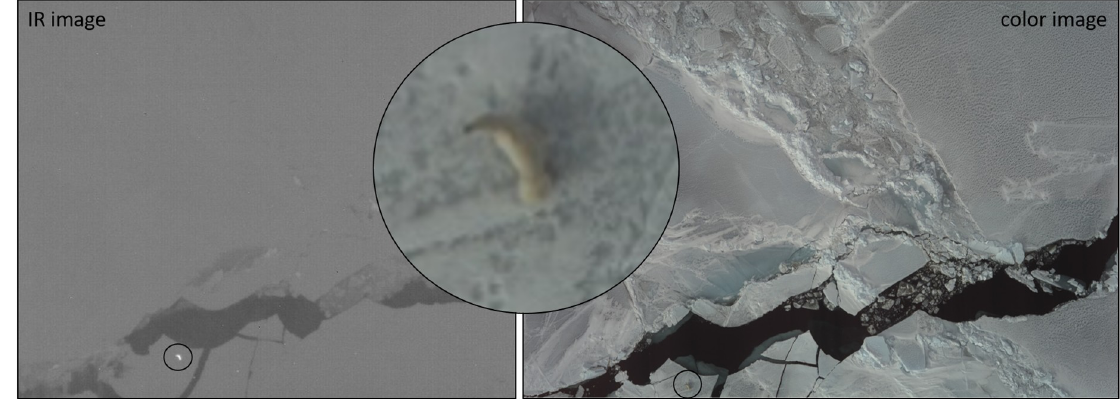
Fig 2. Paired infrared and color imagery of a polar bear. Color (right) and IR (left) imagery collected from 300 m during the 2016 aerial surveys from the U.S. platform containing a polar bear (zoomed inset). The IR image collected with the long wavelength infrared cooled camera (FLIR A6750sc SLS) provides a visual representation of apparent temperature in greyscale where darker shades are cool and lighter shades are warm. The paired color image, collected with the Prosilica GT6600c fitted with a 100 mm Zeiss lens, confirms that the heat signature detected in the IR image is from a polar